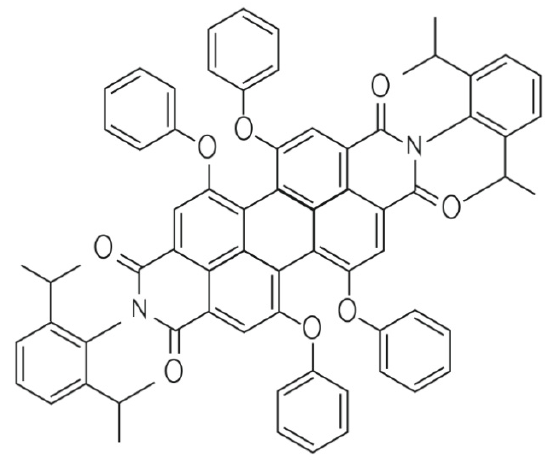
(cid:48) -bis (2,6-di-isopropylphenyl) organic Figure 6. Structure of C 72 H 58 N 2 O 8 (N, N ′ -bis (2,6-di-isopropylphenyl) organic luminophore. Figure 6. Structure of C 72 H 58 N 2 O 8 (N, N